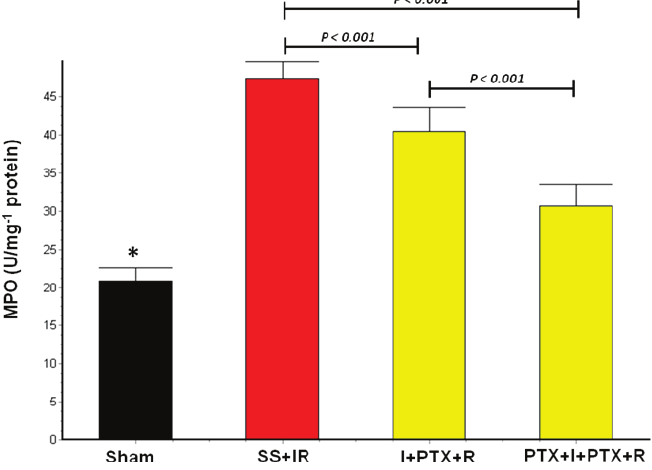
FIGURE 3 - Effect of pentoxifylline treatment on the myeloperoxidase (MPO) activity in rat lung homogenates. Groups are as in the legend to Figure 1. Data are mean ± SD. * P <0.001 regarding all other groups.